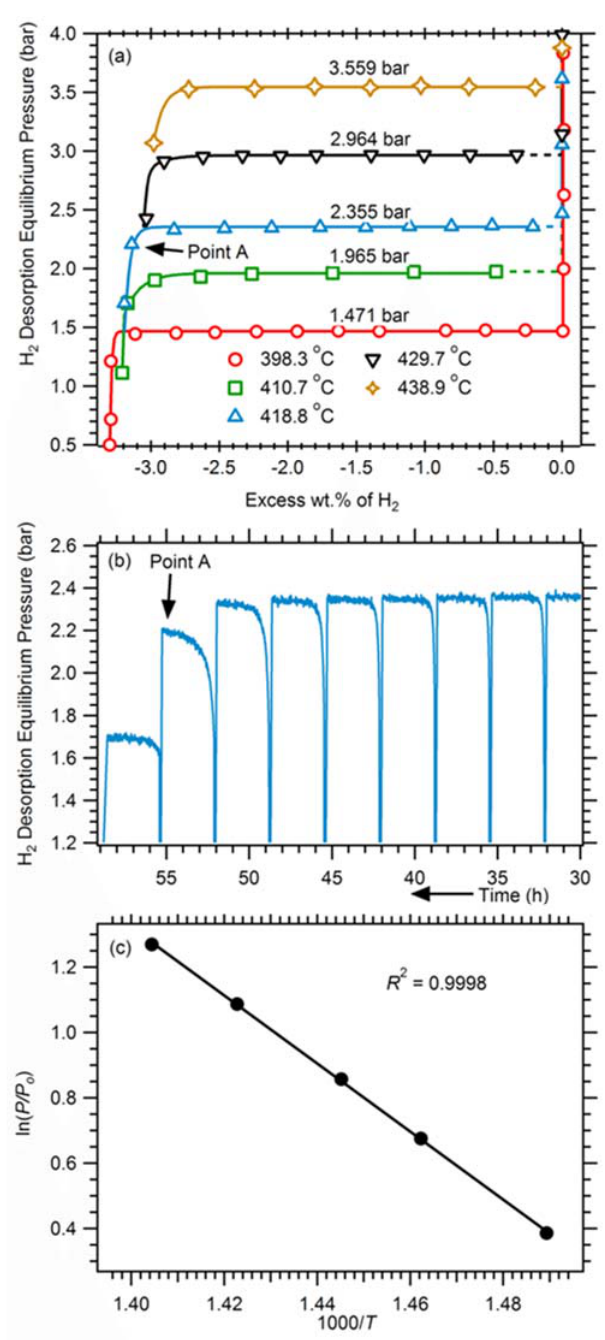
Figure 7. ( a ) Hydrogen desorption PCI curves for NaMgH 3 → NaH + Mg + H 2 performed at different temperatures. Hydrogen desorption equilibrium data points below ~3 wt % desorption have been truncated for clarity while dashed lines indicate inferred data. ( b ) Kinetic H 2 desorption data of NaMgH 3 → NaH + Mg + H 2 performed at 418.8 °C. ( c ) van’t Hoff plot of H 2 desorption equilibrium pressures and the linear fit to the data. Reproduced with the permission from [70], Copyright American Chemical Society, 2011.